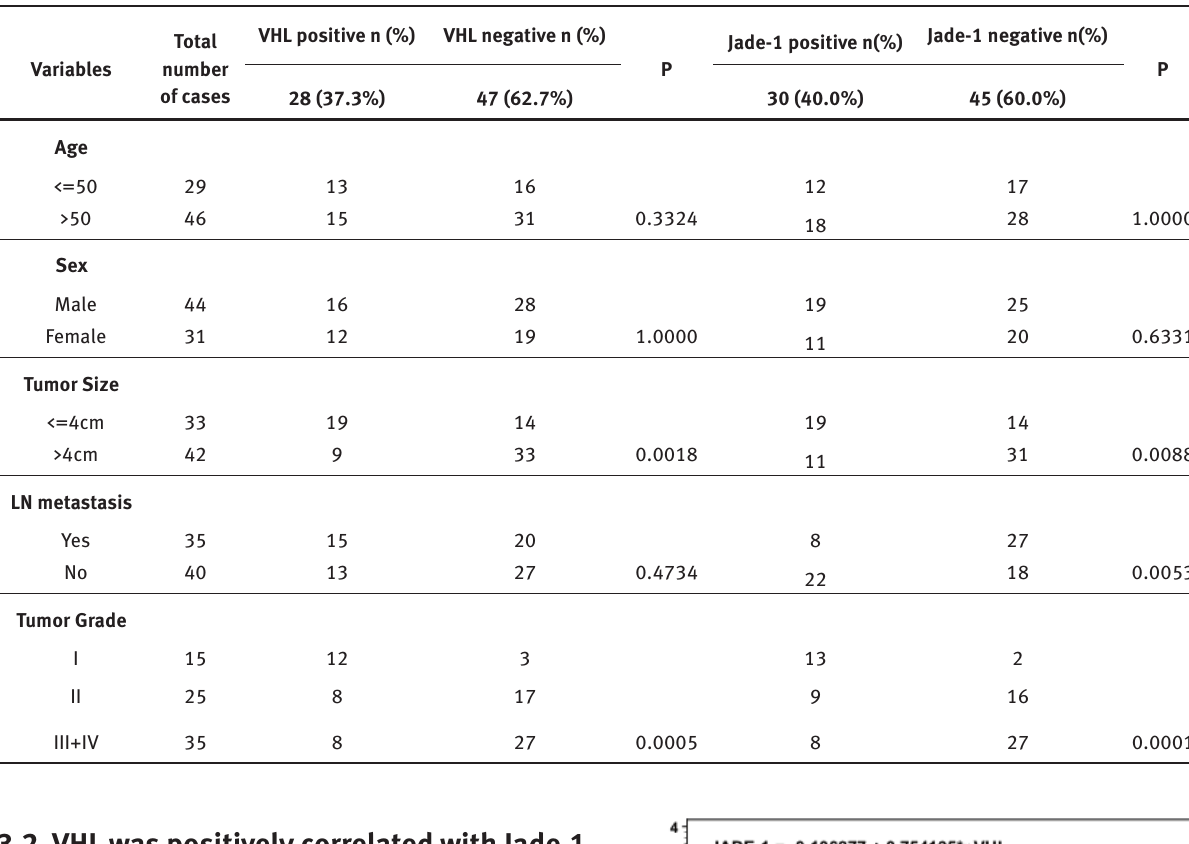
Table 1: Relationship between mRNA expression of both VHL and Jade-1, and age, sex, tumor size, lymph node metastasis and tumor grade in RCC.